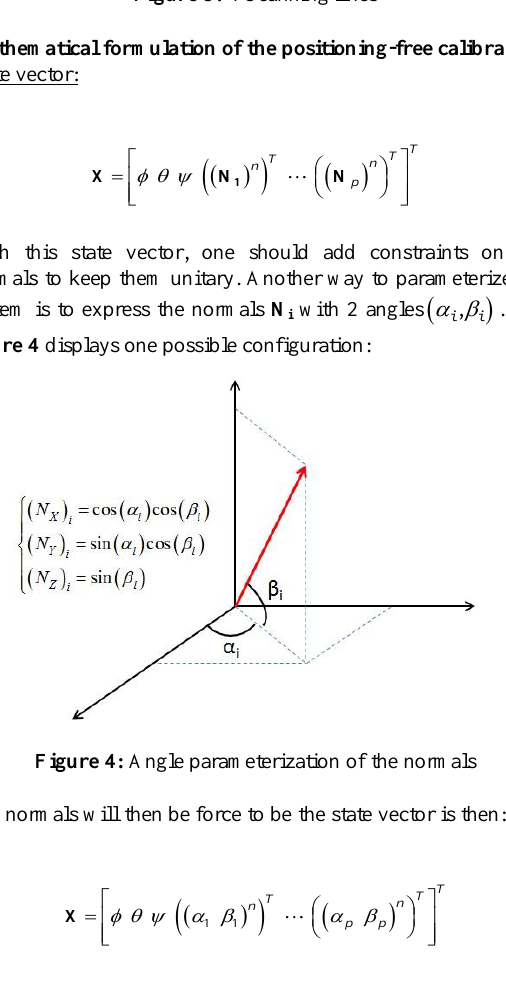
Figure 3: 4 Scanning lines